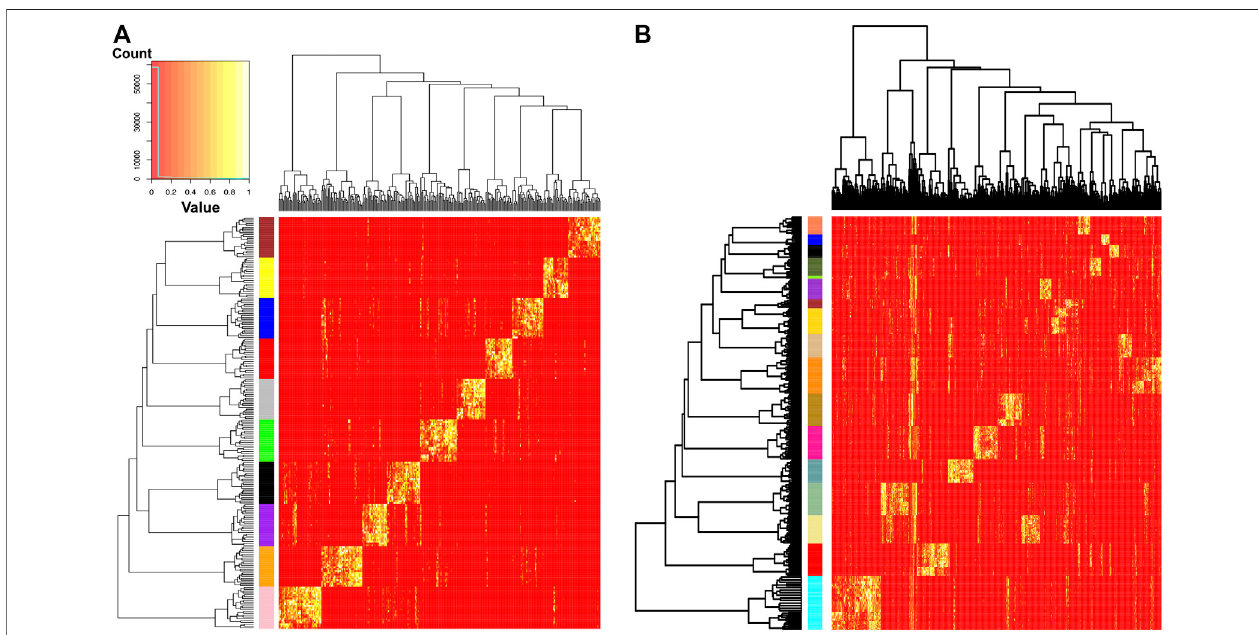
FIGURE 3 | Identi fi cation via heatmap of Σ PSS . Each row indicates a segment of gait time, and rows from the same subject are labeled in the same color; each columnindicates aselectedPSS. (A) MAREAdatabase:10subjects.Thequantiles α (cid:2) 0 . 3and β (cid:2) 0 . 7. N * ((cid:2) 300 ) principlesystem-statesbasedonninedimensionsof gaittimeseriesderivedfromthreesensors fi xedattheleftfoot,rightfoot,andwrist. (B) HuGaDBdatabase:17subjectswithsixsensorstiedtoleftandrightthighs,shins, and feet. The quantiles α (cid:2) 0 . 1 and β (cid:2) 0 . 9. N * ((cid:2) 500 ) principle system-states based on 18 dimensions of gait time series.